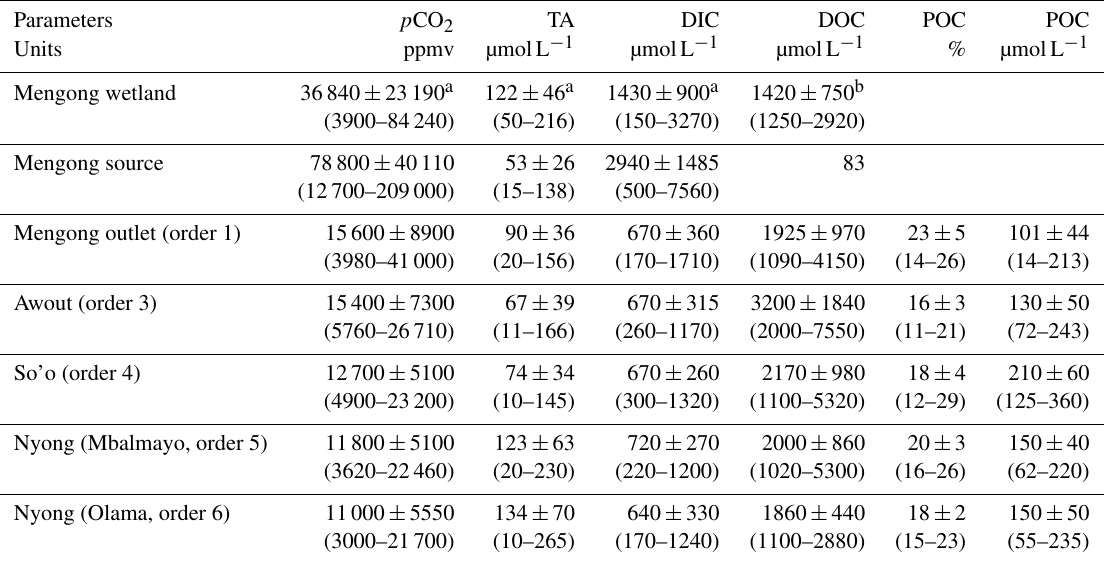
Table 3. Spatial distribution of C variables (yearly average ± standard deviation) in waters of the Nyong watershed during the sampling year 2016. The range is shown in square